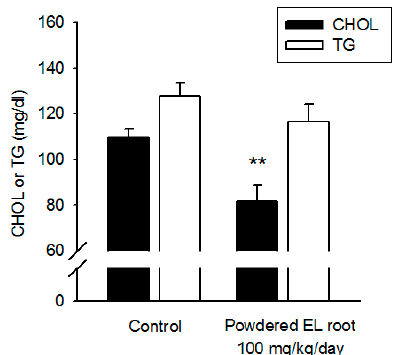
Figure 4. E. longifolia manifested a lipid-lowering effect in db/db mice. The amount of cholesterol and triglyceride in sera has been measured as described in Materials and Methods. A significant reduction in cholesterol was observed in the high- and middle-dose EL-treated groups, whereas the triglyceride level remained unaltered. (** p < 0.01, indicates a statistically significant difference from the control group).